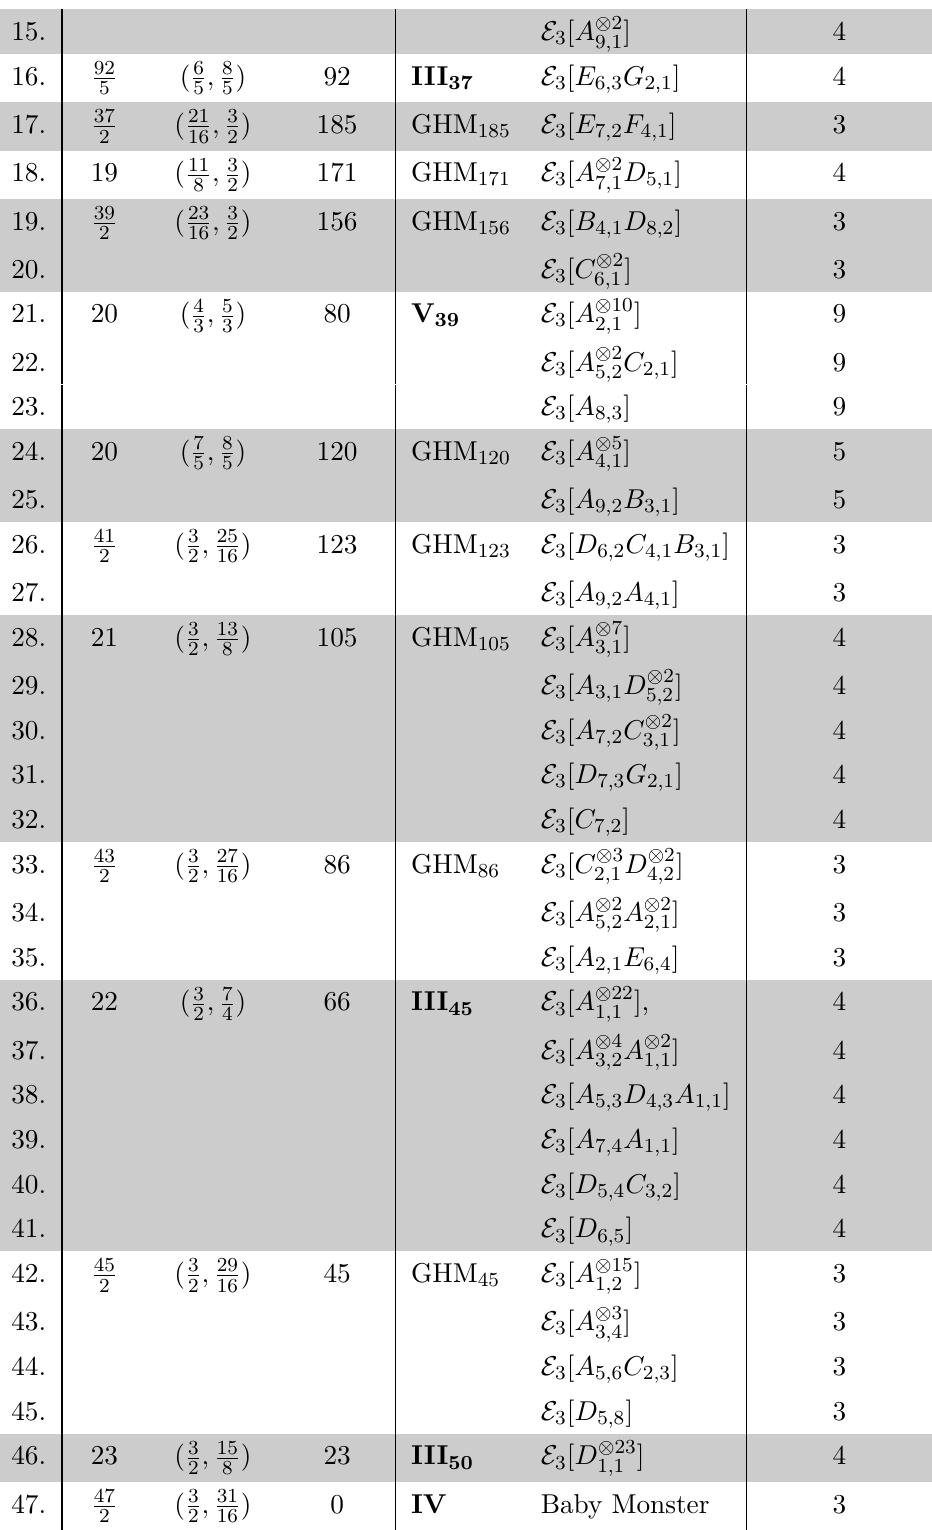
Table 28. Complete list of unitary (3 , 0) CFTs (except unitary CFTs at c = 8 , 16